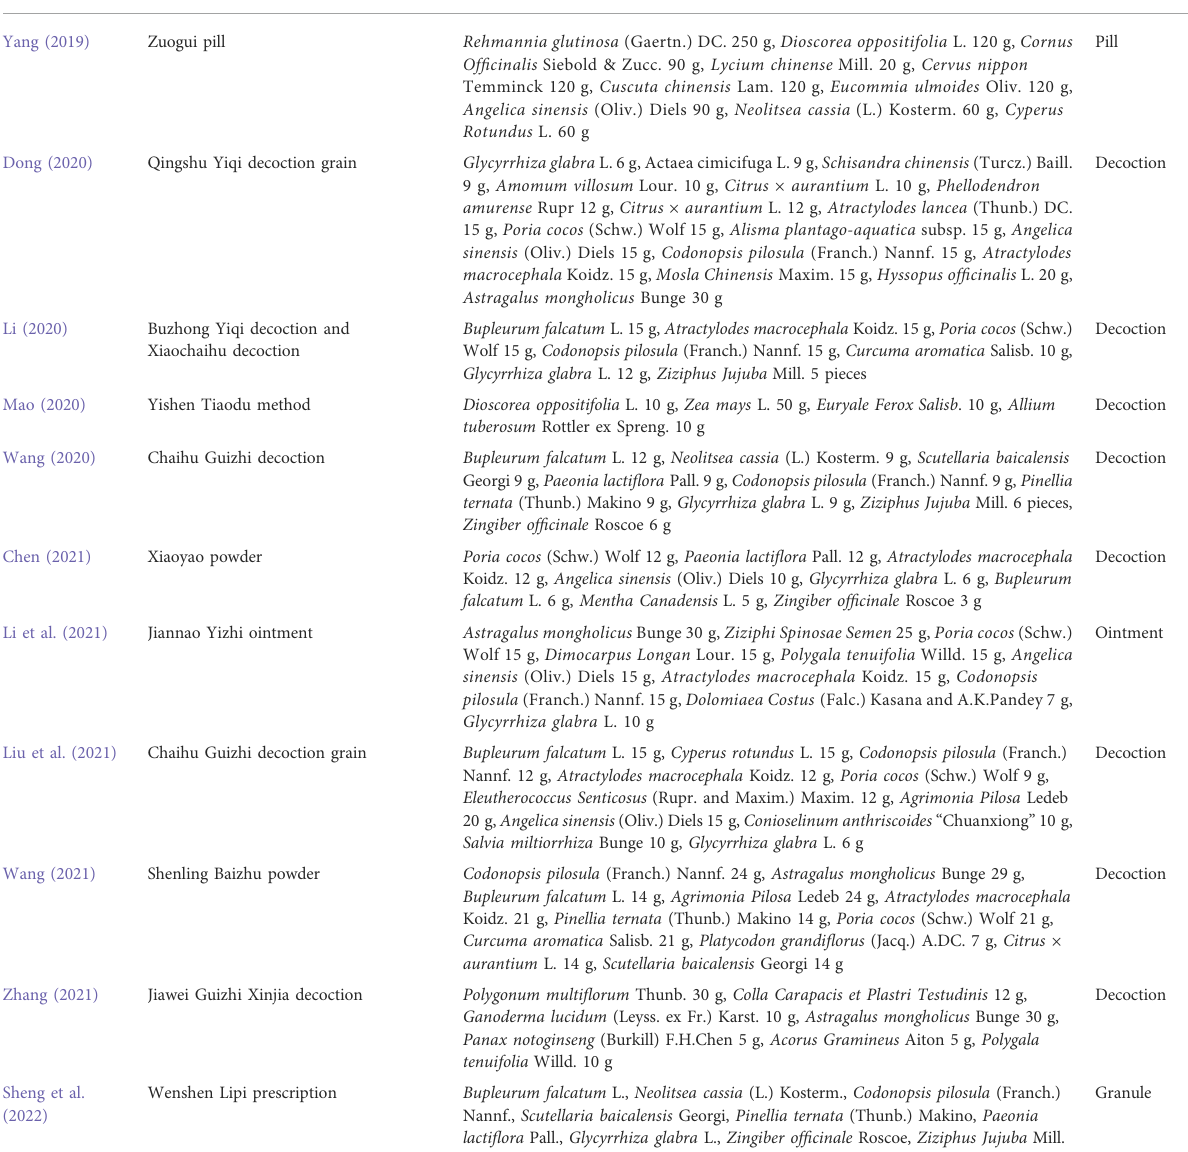
details of the protocol are available on